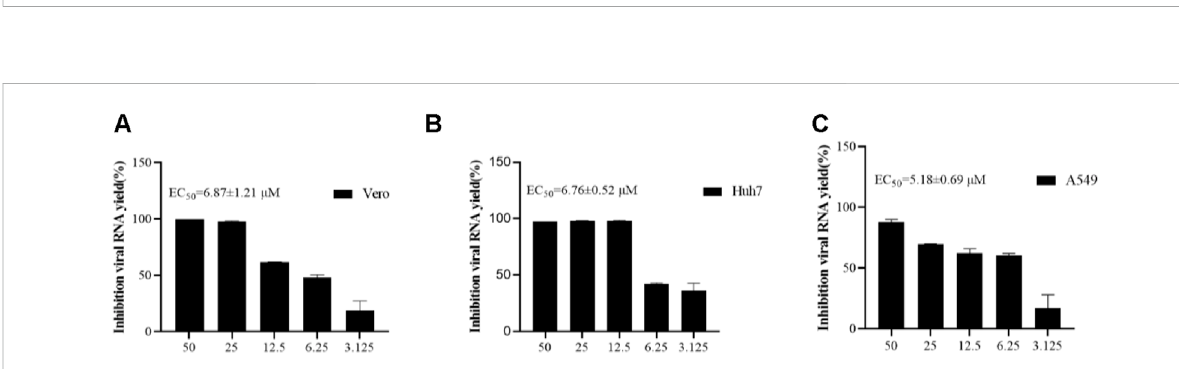
FIGURE 8 Compound 4w inhibits virus release of ZIKV progeny in different cell lines. (A) Vero cells; (B) Huh7 cells; (C) A549